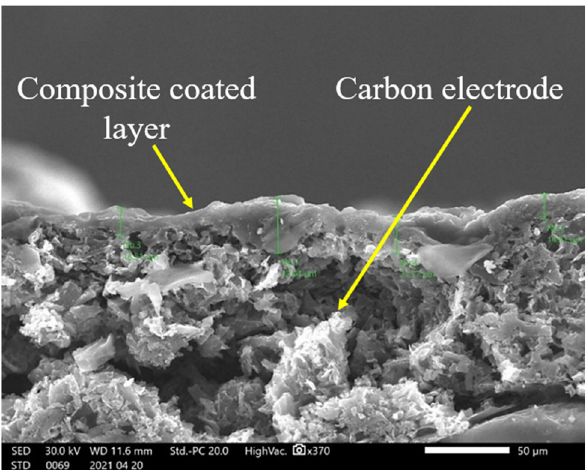
Figure 7: The conductivity as a function of desalination time for